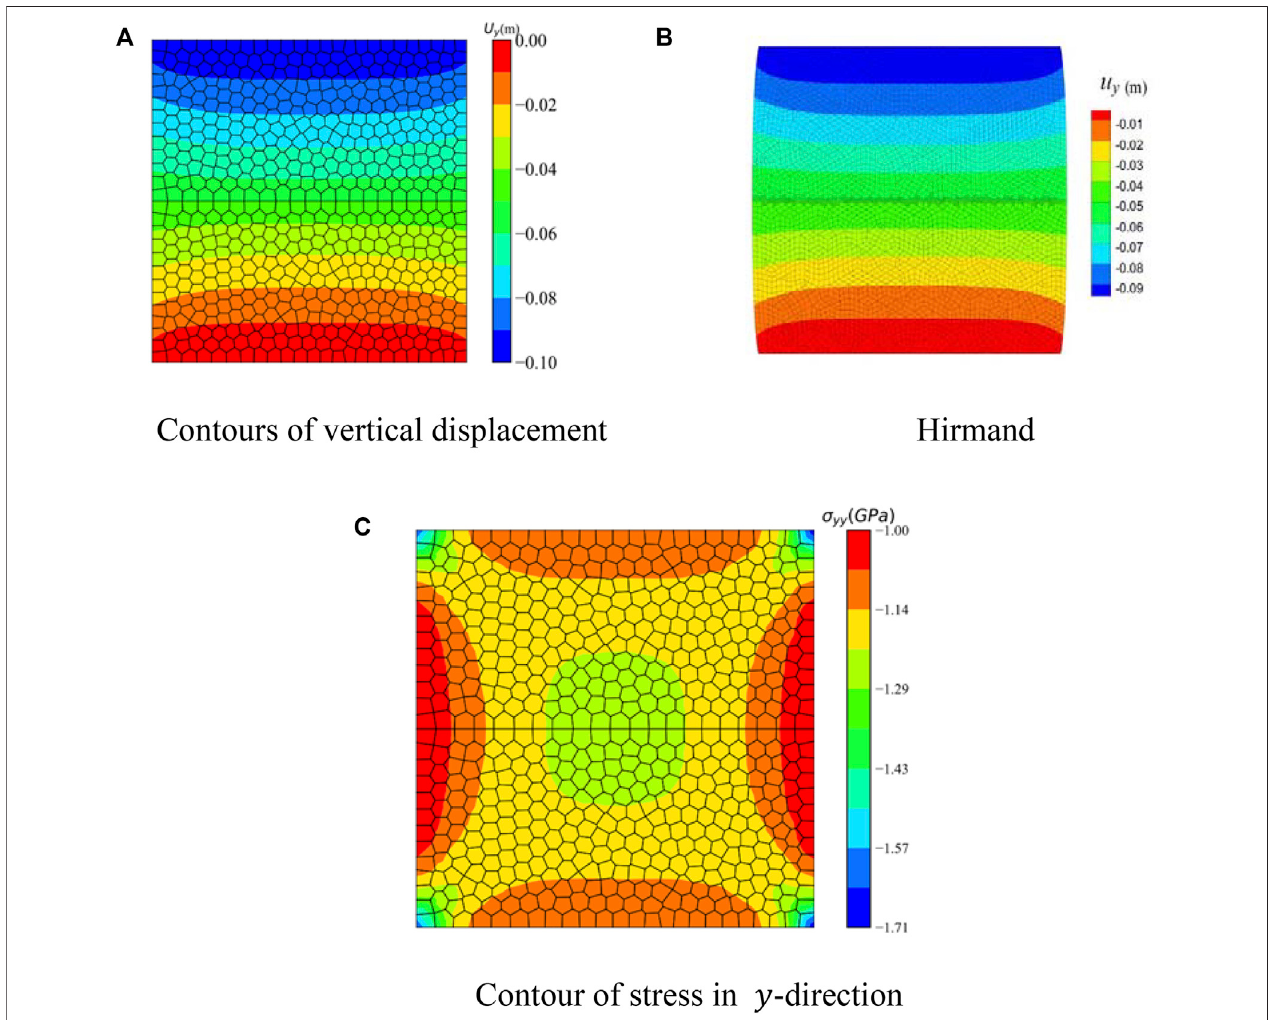
FIGURE 11 | Contours of displacement and pressure for the vertical direction ( U y is the displacement in y -direction and σ yy is the stress in y -direction).